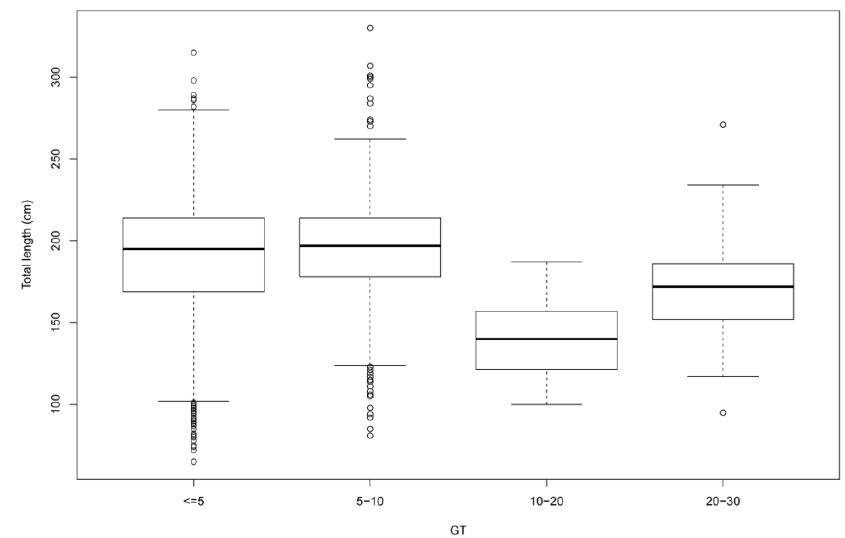
Figure 3. Boxplot of total length of silky sharks landed in Tanjung Luar and Cilacap based on fishing vessel size (Gross Tonnage (GT)).